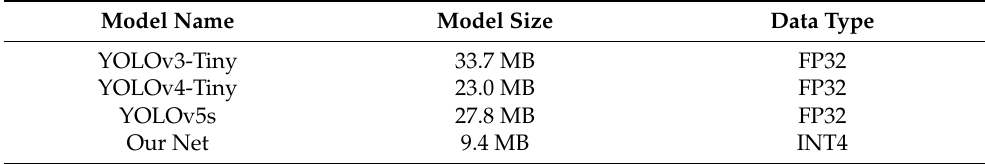
Table 1. Comparison with other model